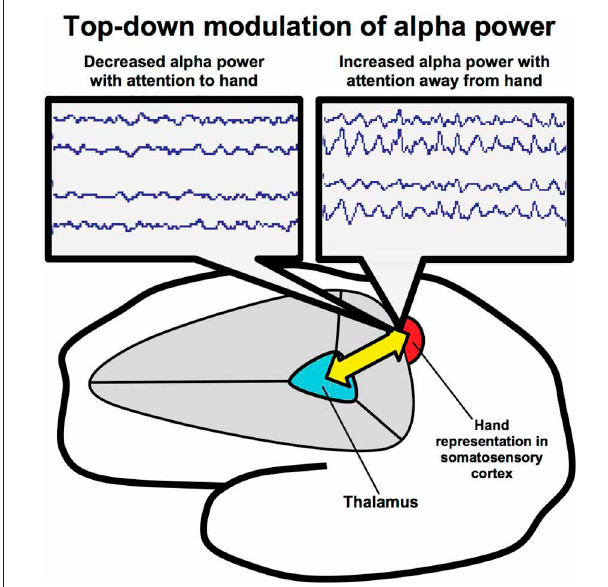
FIGURE 2 | Thalamocortical circuitry involved in ST-Mindfulness and somatosensory attentional modulation of alpha rhythms. Attentionally driven increases in alpha rhythm power broadly suppress sensory throughput in the unattended area (via thalamocortical mechanisms); spatially specific suppression of alpha facilitates sensory throughput in the attended area from the sensory periphery to the thalamus and on to the cortex.